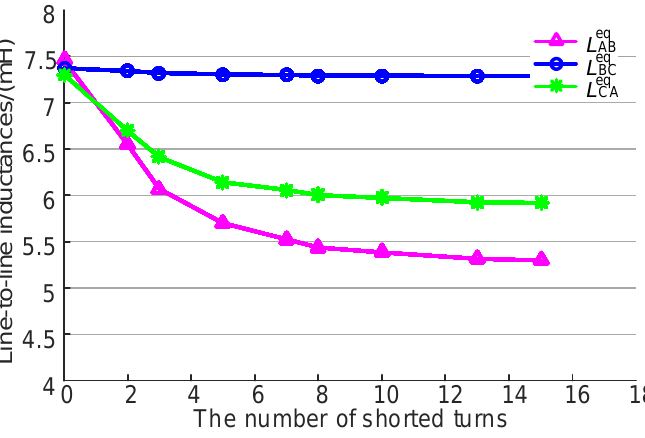
Figure 7. Line-to-line inductance under different numbers of the shorted turns. According to Equations (16) and (17), the stator fault indicators FI R and FI ∆ R can be calculated through the measured data. These two fault indicators under different fault severities are performed, as the curves shown in Figures 8 and 9. In Figure 8, the fault indicator FI R increases with the number of shorted turns from 0.182% to 2.565%. Figure 9 shows that the fault indicators FI ∆ R AB and FI ∆ R BC increase from 0% to 3.475%, whereas FI ∆ R CA is almost unchanged (nearly 0), which indicates that phases B and C are healthy and phase A has a stator fault. Therefore, the fault indicator FI R can determine whether the motor has a stator fault, and the FI ∆ R AB , FI ∆ R BC , and FI ∆ R CA can identify the fault phase.